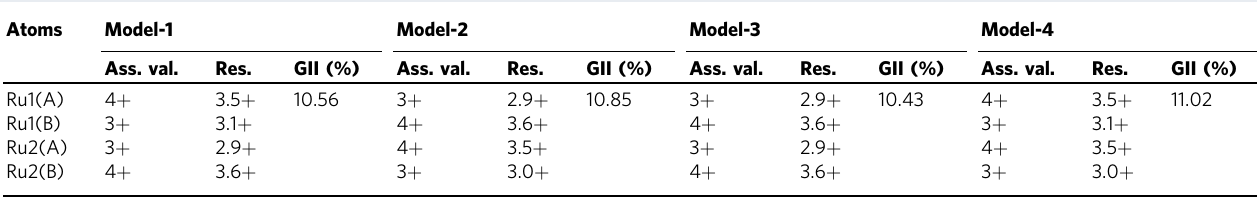
Table 4 The four different models corresponding to four options for two dimers: counting from the left, (3 + , 4 + ) in the upper dimer, (3 + , 4 + ) in the lower dimer.